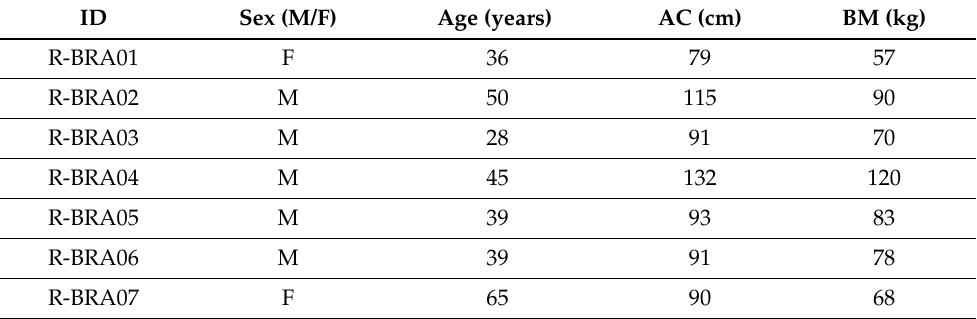
Table 3. Characteristics of each